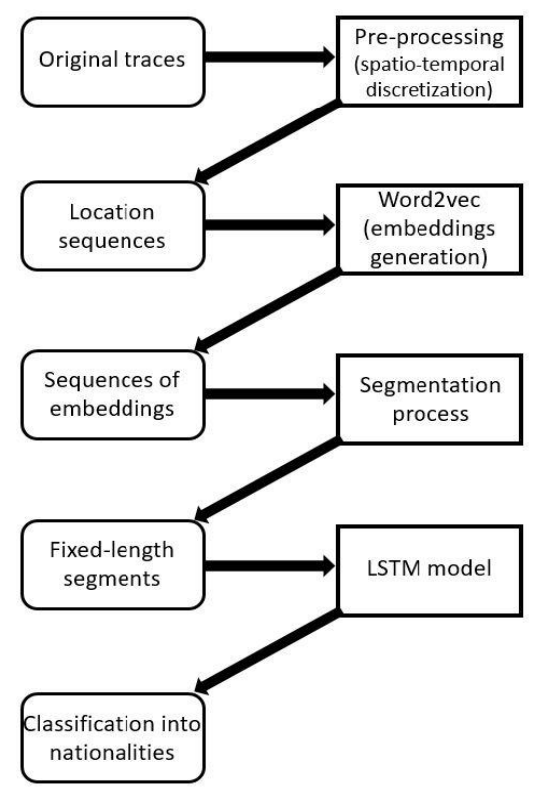
Figure 3. Flowchart of the whole classification process.